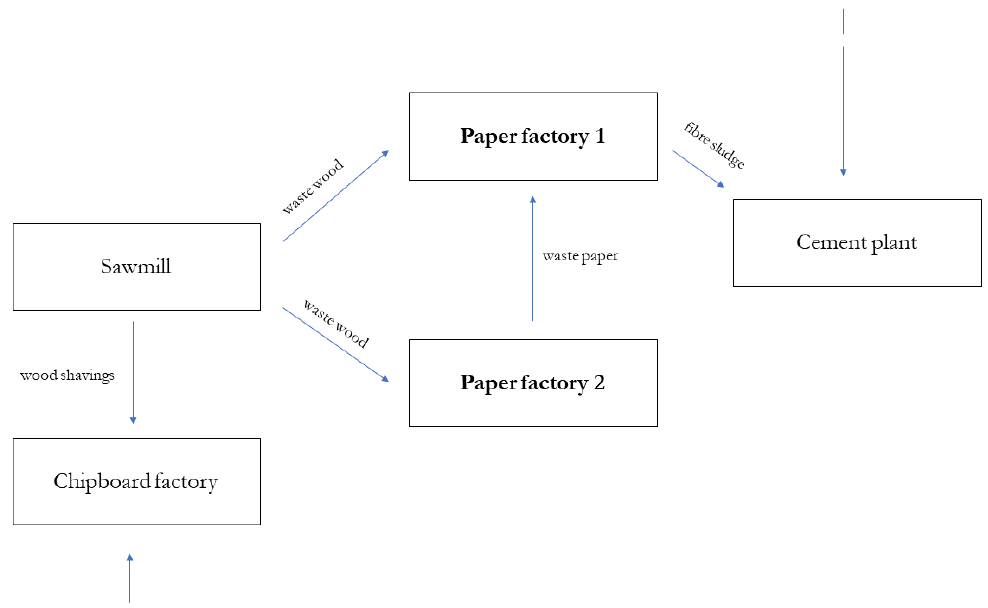
Figure 1. Part of the Styria recycling